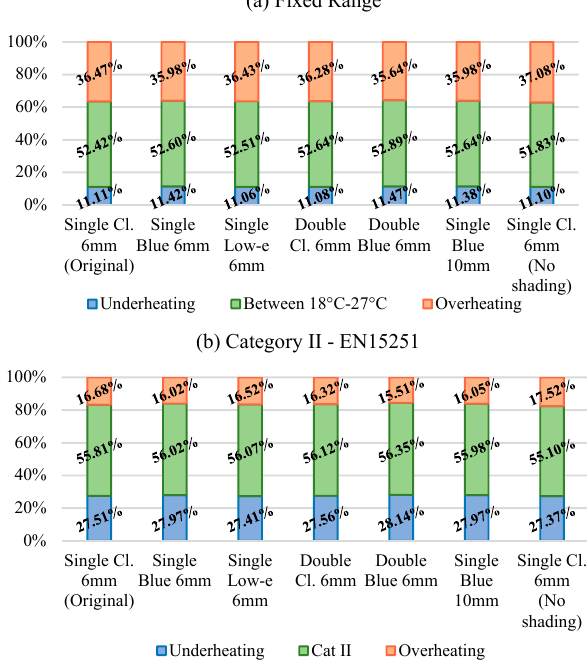
Figure 3. Comfort rates according to the fixed range ( a ) and the EN15251 for Category II ( b ) considering different glazing types.